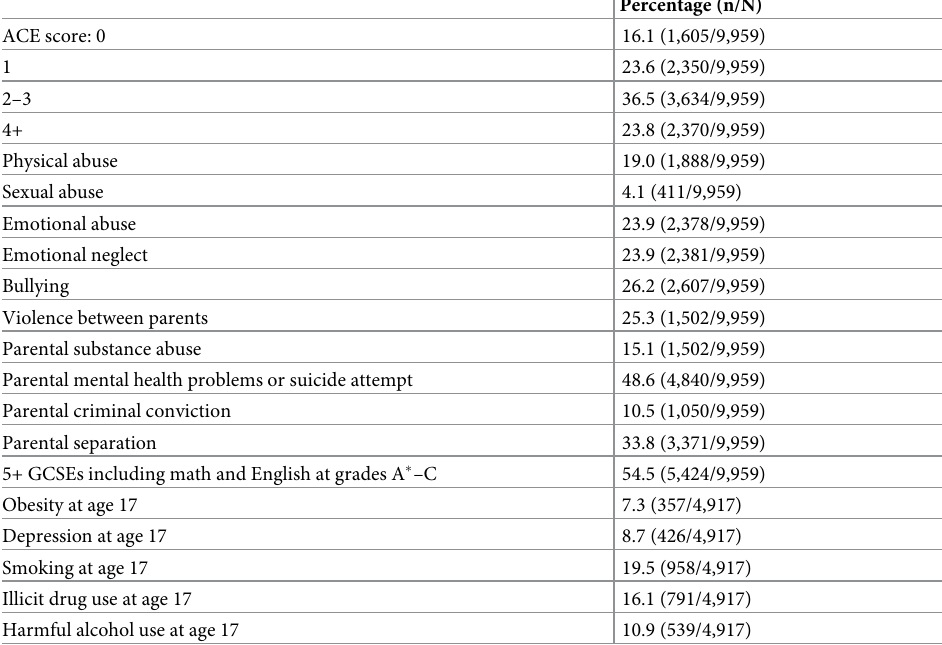
Table 1. Participant characteristics. Characteristics of the participants included in analyses using data from multi- variate multiple imputation. Because the data are from multiple imputation models, numerators and denominators are estimated by averaging across imputed data sets. All prevalences reported here relate to the data sets used for analysis of educational attainment, N = 9,959, apart from health outcomes, where N =